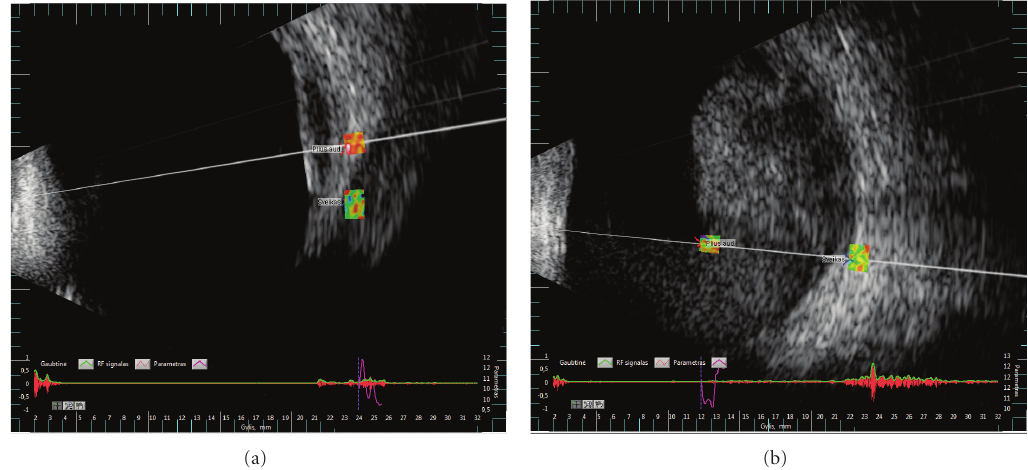
Figure 1: Representative examples of B-scan images with manually selected regions: (a) in healthy orbit and extraocular muscle (case no. 164), (b) in healthy orbit and intraocular blood (case no. 84). Table 1: The list of parameterization algorithms and extracted